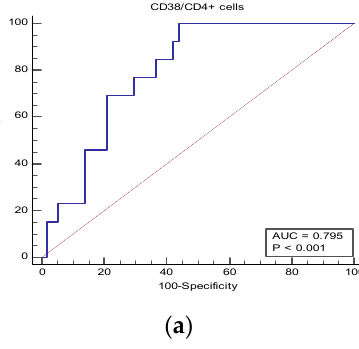
Figure 6. ROC curve: ( a ) CD38/CD4 + cells; ( b ) CD38/CD8 + cells to predict mortality among patients of the three studied groups. Table 8. ROC analysis of CD38/CD4 + cells and CD38/CD8 + cells to predict mortality among patients of the three studied groups.